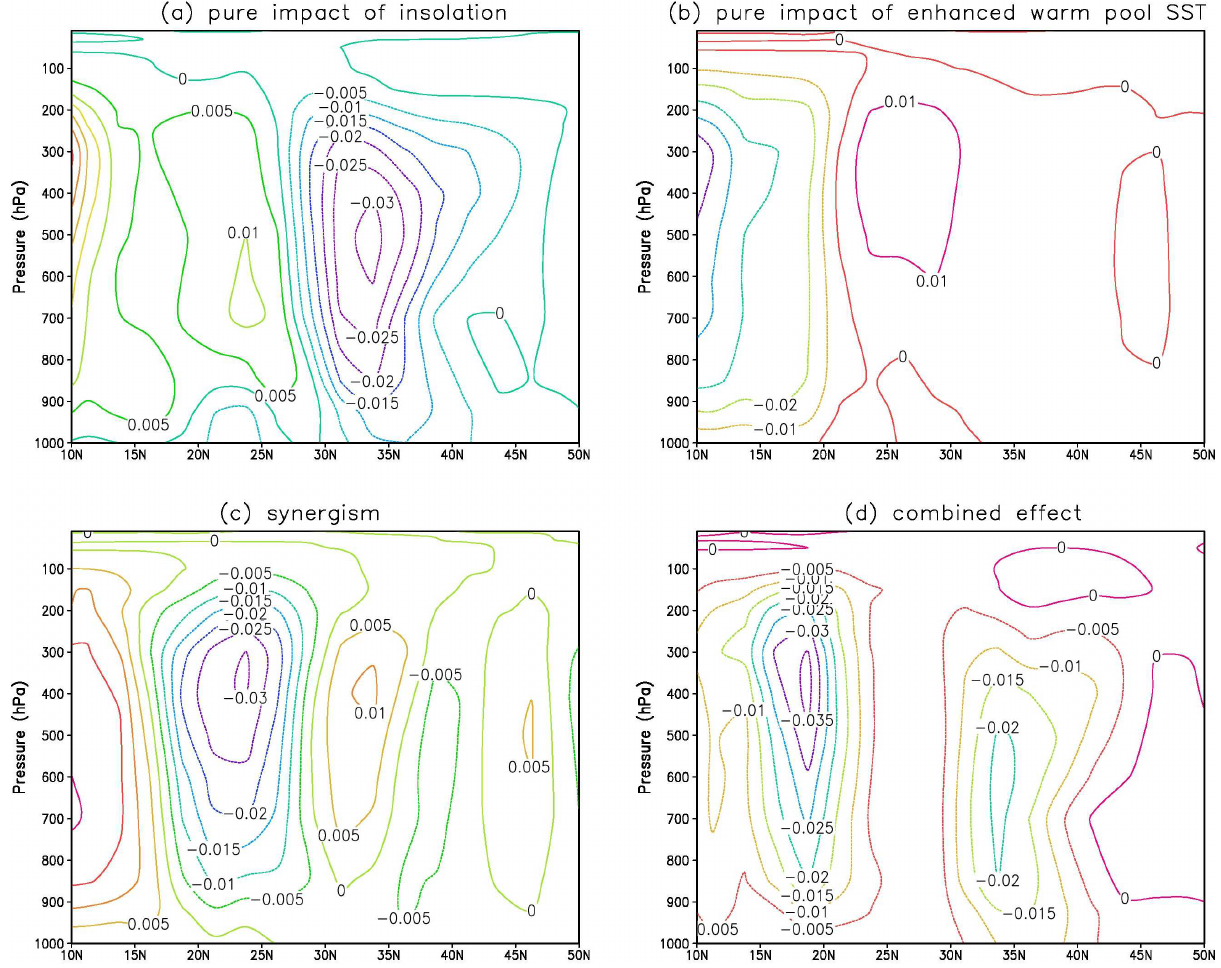
Figure 7. Same as Figs. 2 and 4 except for summer vertical velocity anomaly (Pas − 1 ) averaged over 105 to 120 ◦